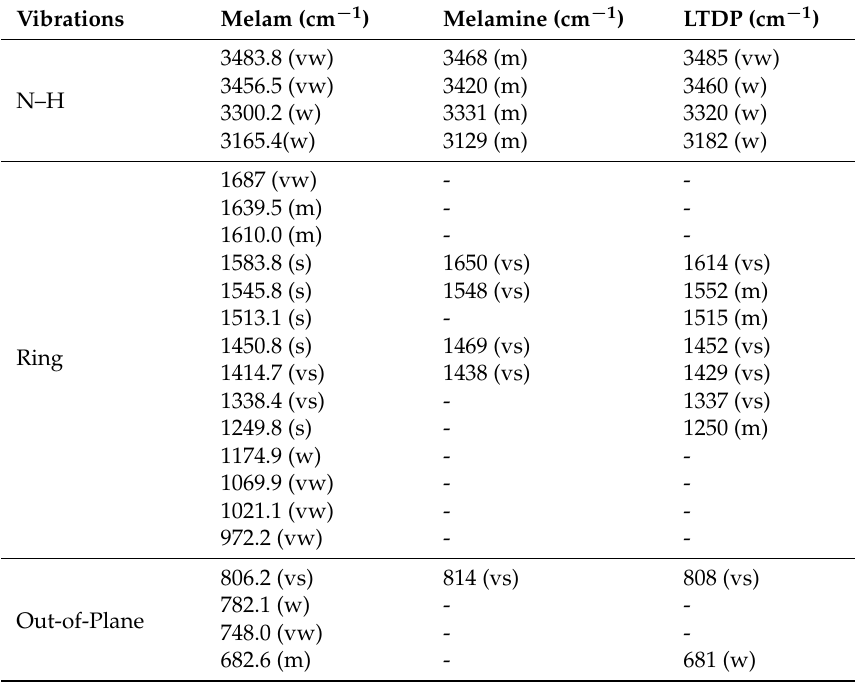
Table 1. Vibrational frequencies (cm − 1 ) of melam, melamine, and LTDP